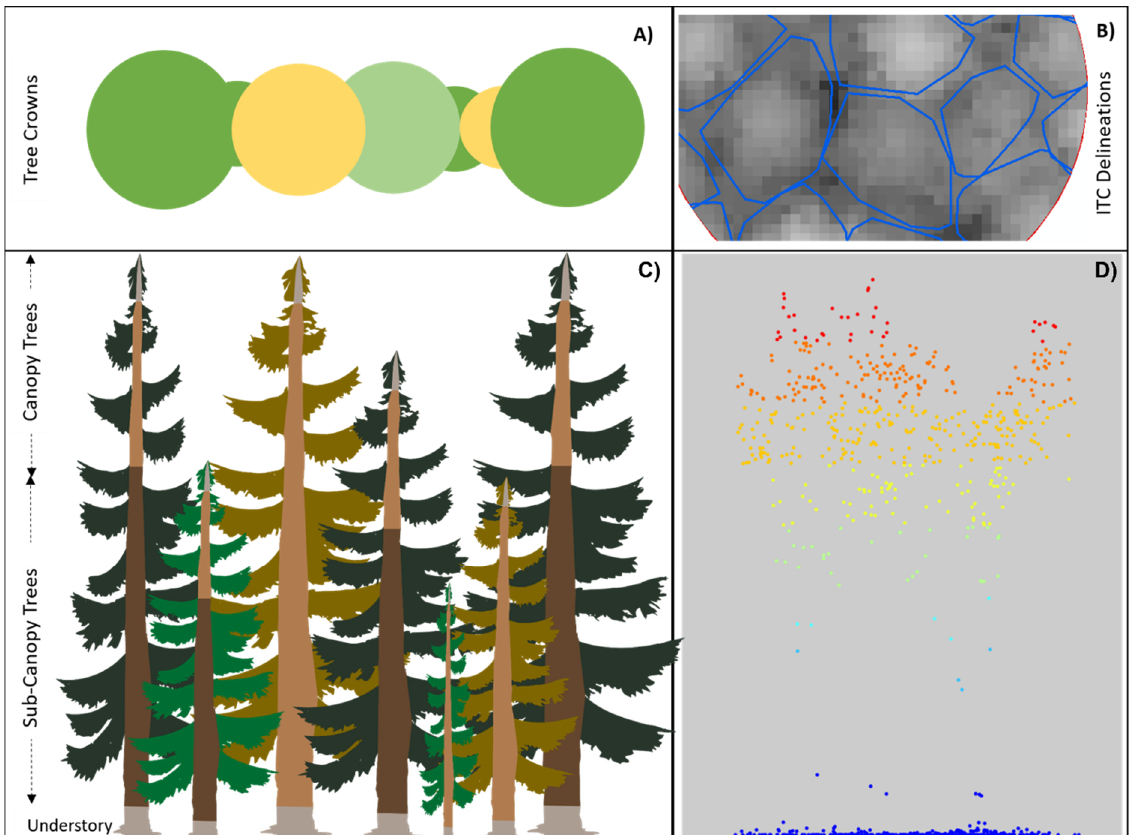
Figure 2. ( A ) Diagram depicting the areal appearance of the canopy and sub-canopy tree crowns; ( B ) data representations of an individual tree delineation for OR plot 11.3; ( C ) structure of a complex forest with live (dark and light green crown, respectively) and dead (yellow crown) trees that make up the canopy and sub-canopy. Also shown are the stem wood components of merchantable stem wood ( ≥ 12.5/17.5 cm DBH and 10 m length) (dark brown), non-merchantable stem wood ( ≥ 10 cm diameter and <10 m length) (light brown), and stumps and tops (grey). ( D ) Corresponding LiDAR point cloud for OR plot 11.3.